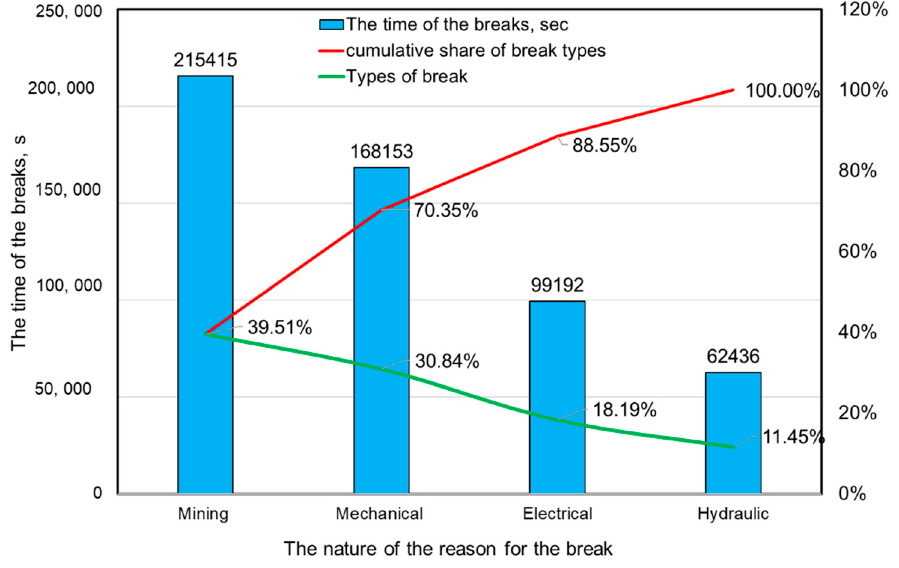
Figure 12. Time of individual types of break causes with their percentage share (cumulative share of break types).